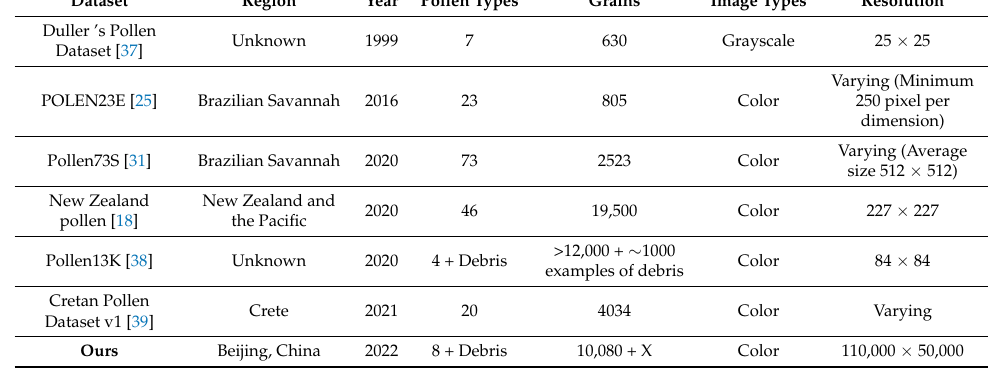
Table 1. The list of publicly available pollen datasets (all other unknown pollens are aggregated in an “X” category).